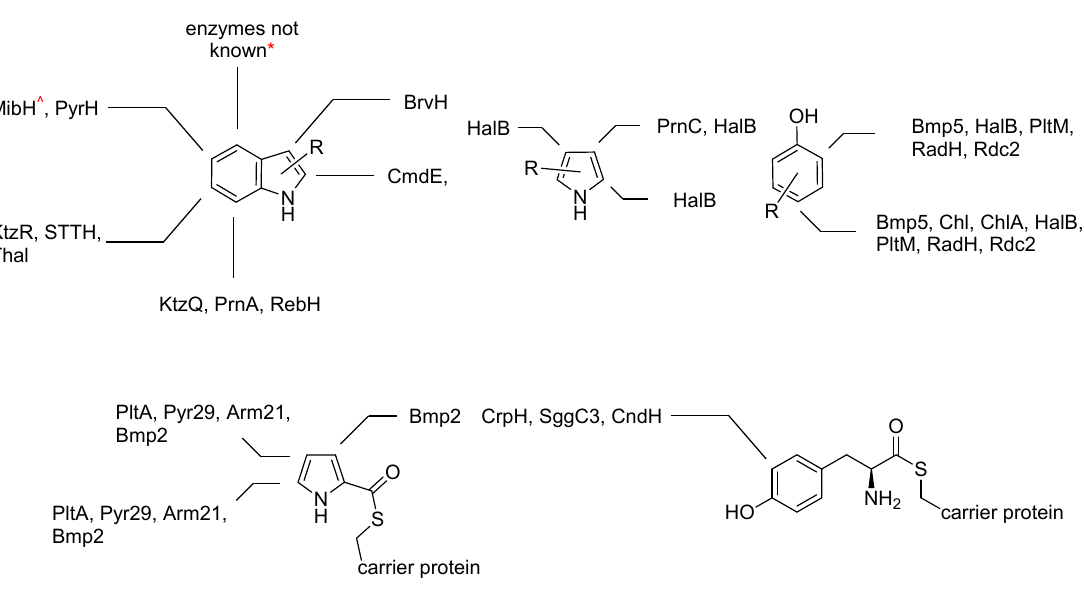
Table 3. Examples of flavin-dependent tryptophan, pyrrole and phenol halogenases that can be carrier-dependent or independent. Enzyme